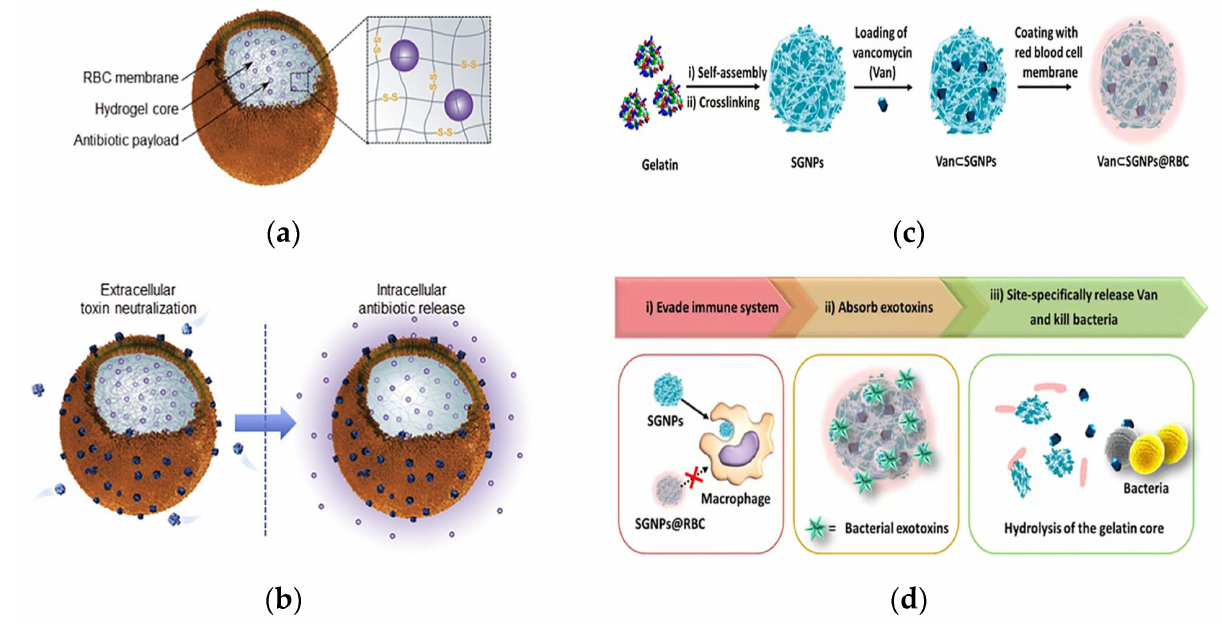
Figure 7. Schematic of an erythrocyte membrane-encapsulated drug delivery system. ( a ) Schematic of the structural composition of the RBC-nanogel DDS. ( b ) Mechanism of action of the RBC-nanogel DDS. Adapted with permission from [105], Copyright 2017 Elsevier. ( c ) The preparation process of the Van ⊂ SGNPs@RBC. ( d ) Schematic representation of adaptive and multifunctional Van ⊂ SGNPs@RBC in the treatment of a bacterial infection. Adapted with permission from [106], Copyright 2014 American Chemical